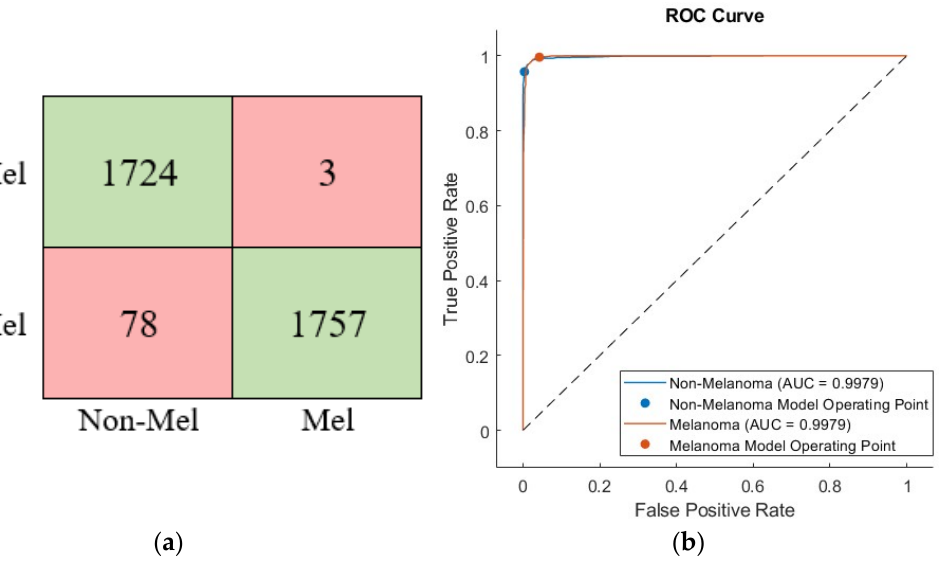
Figure 9. The confusion matrix ( a ) and ROC diagram ( b ) of proposed classifier approach.